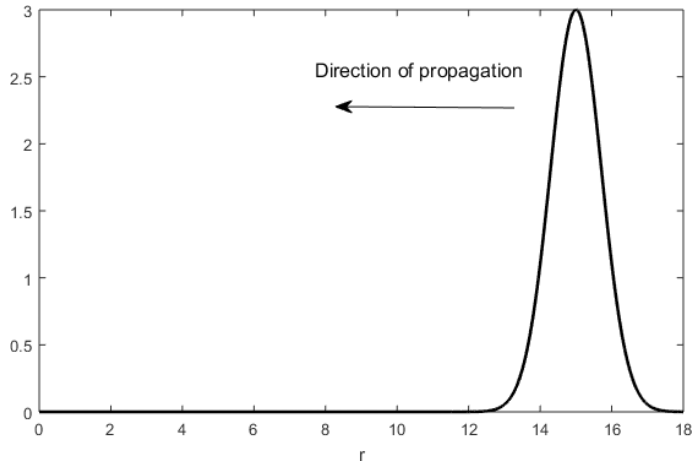
Figure 1. Spatial profile of the initial data.